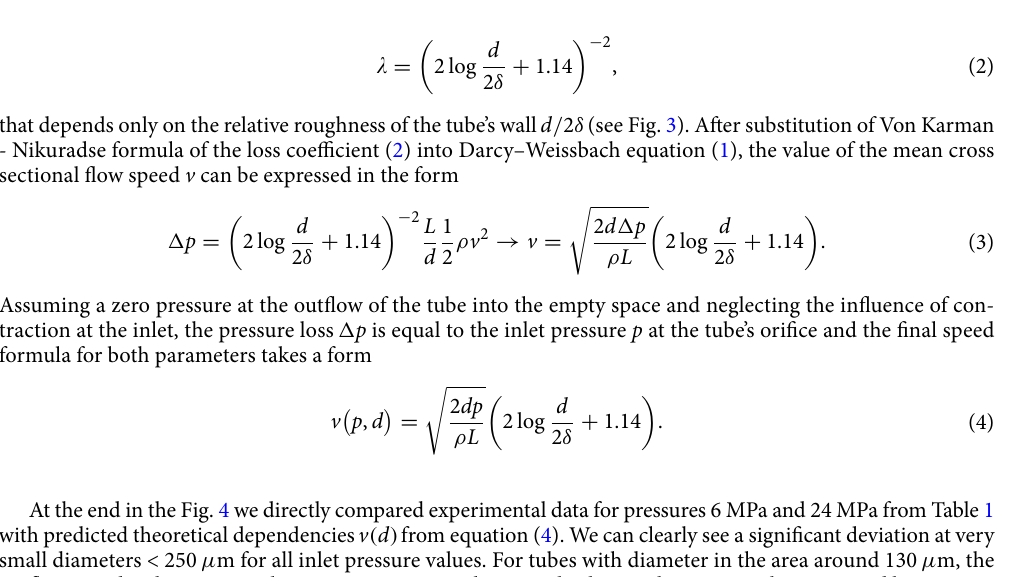
Figure 3. Scanning electron micrograph of the tube’s inner wall. The relative roughness was analysed sectional by Mitutoyo Surftest SJ-401 with the resulting values within the range of 2–4